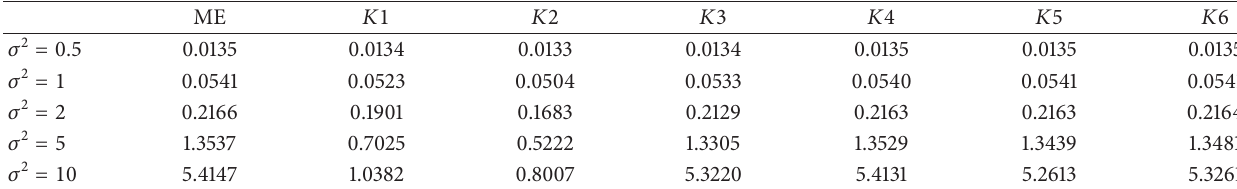
Table 6: Estimated MSE with 𝑛 = 100 , 𝑝 = 4 , and 𝛾 = 0.85 .